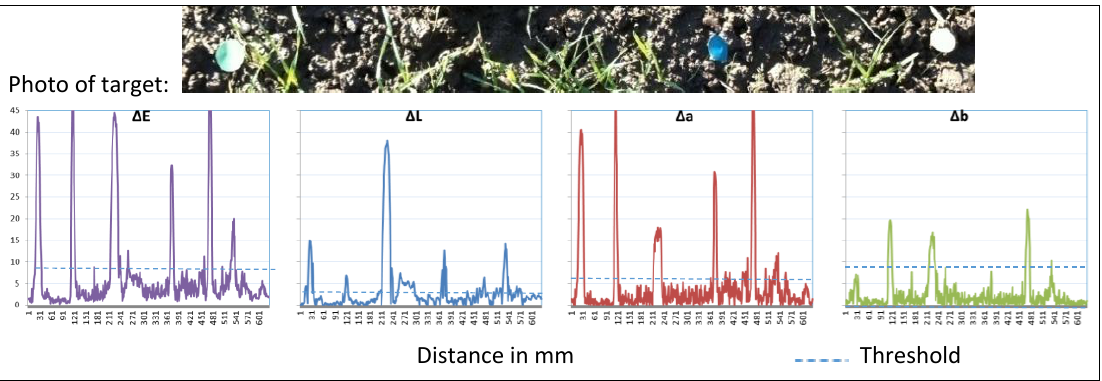
Figure 7. Reflection of a winter wheat field with different colored cards, ∆E, ∆L, ∆a, ∆b and the defined threshold for detection.